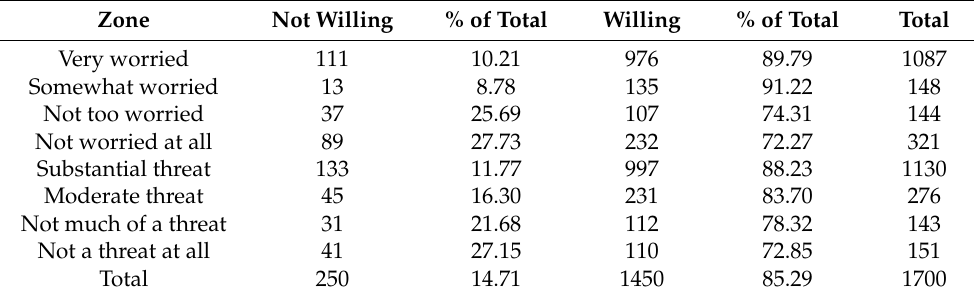
Table 3. Respondents’ Perceptions on Being Worried and Threats Posed by